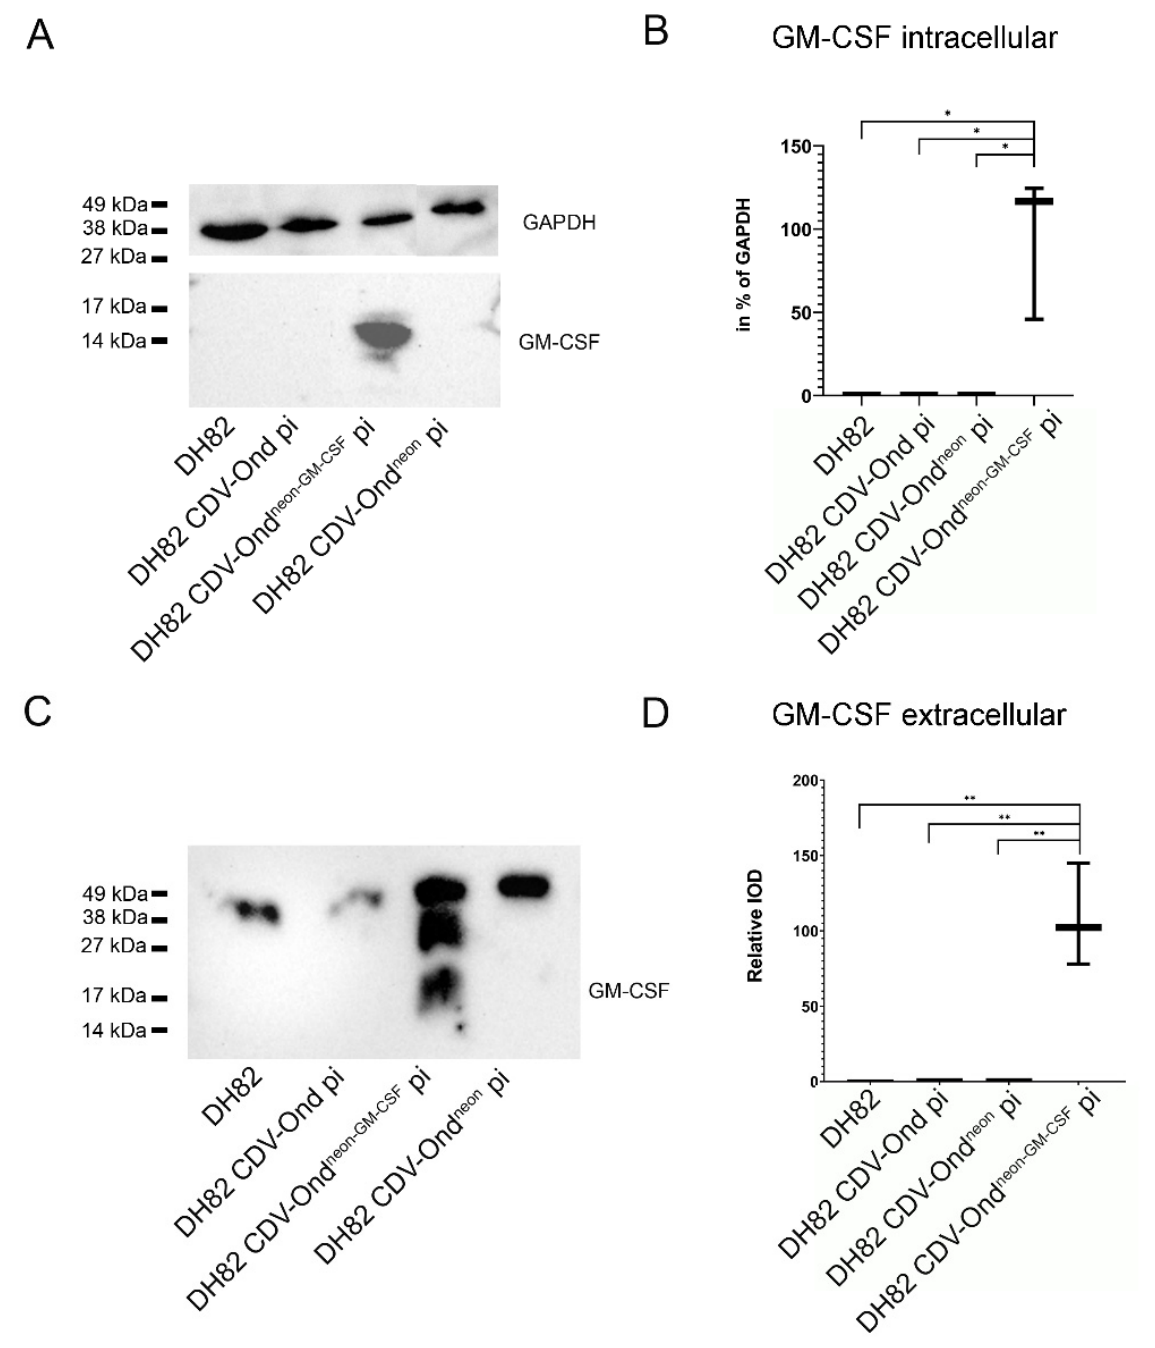
Figure 6. Western blot analysis of the intra- and extracellular amounts of GM-CSF in DH82 cell cultures persistently infected with different CDV strains and non-infected controls. Immunoblotting of intracellular ( A , B ) and extracellular ( C , D ) proteins with a GM-CSF specific antibody revealed bands at 14 kDa only in DH82 cells infected with CDV-Ond neon-GM-CSF ( A , C ). ( B , D ) DH82 cells infected with CDV-Ond neon-GM-CSF revealed significantly more GM-CSF both intracellularly ( B ) and within the culture supernatant ( D ) than non-infected controls and DH82 cells persistently infected with CDV-Ond or CDV-Ond neon . Box plots represent minimum, median and maximum. Significant differences (Mann–Whitney-U test) are labeled by asterisks: * = p ≤ 0.05, ** = p < 0.01. IOD—integrated optical density.